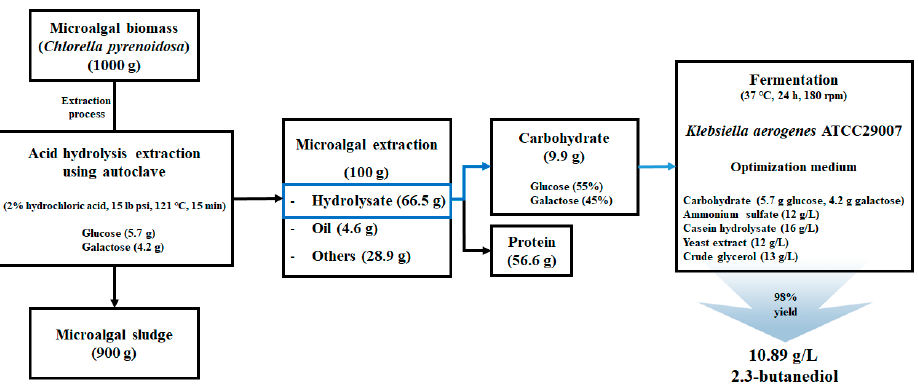
Figure 4. Schematic diagram of mass balance for 2,3-butanediol based on microalgal biomass.